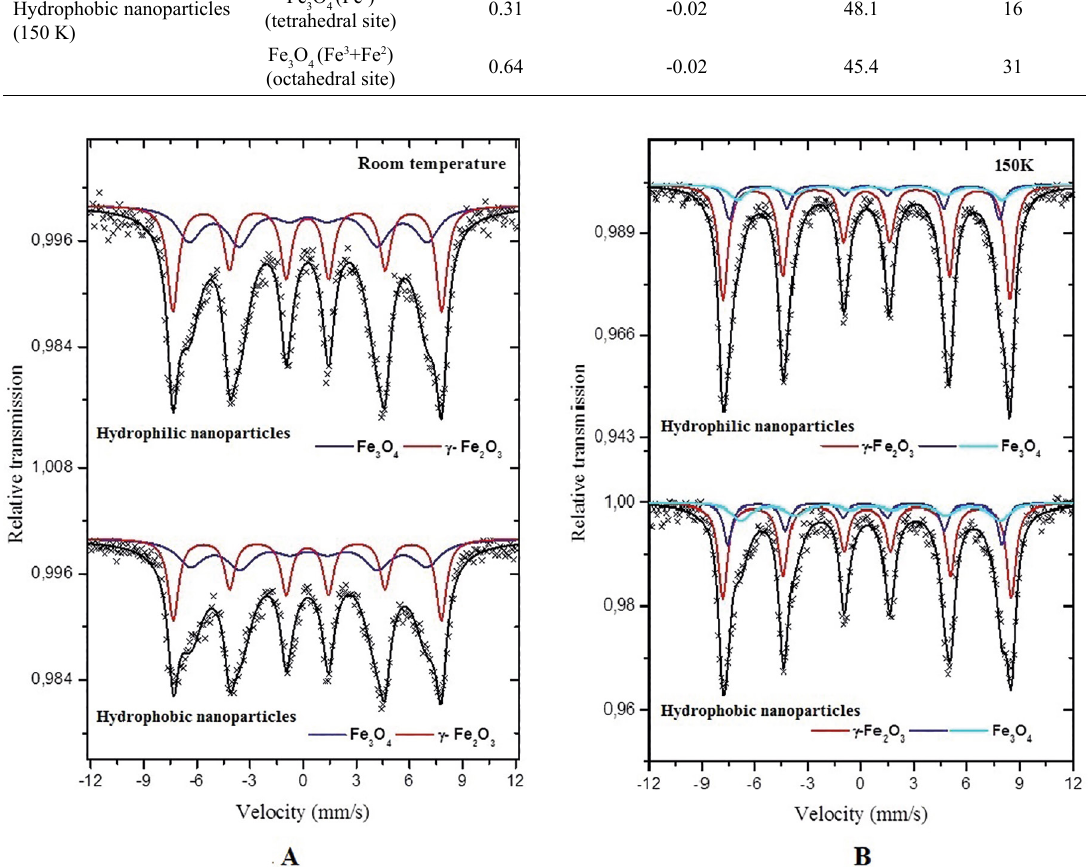
Figure 5. Mössbauer spectra of the magnetic nanoparticles at room temperature (A) and 150 K (B).